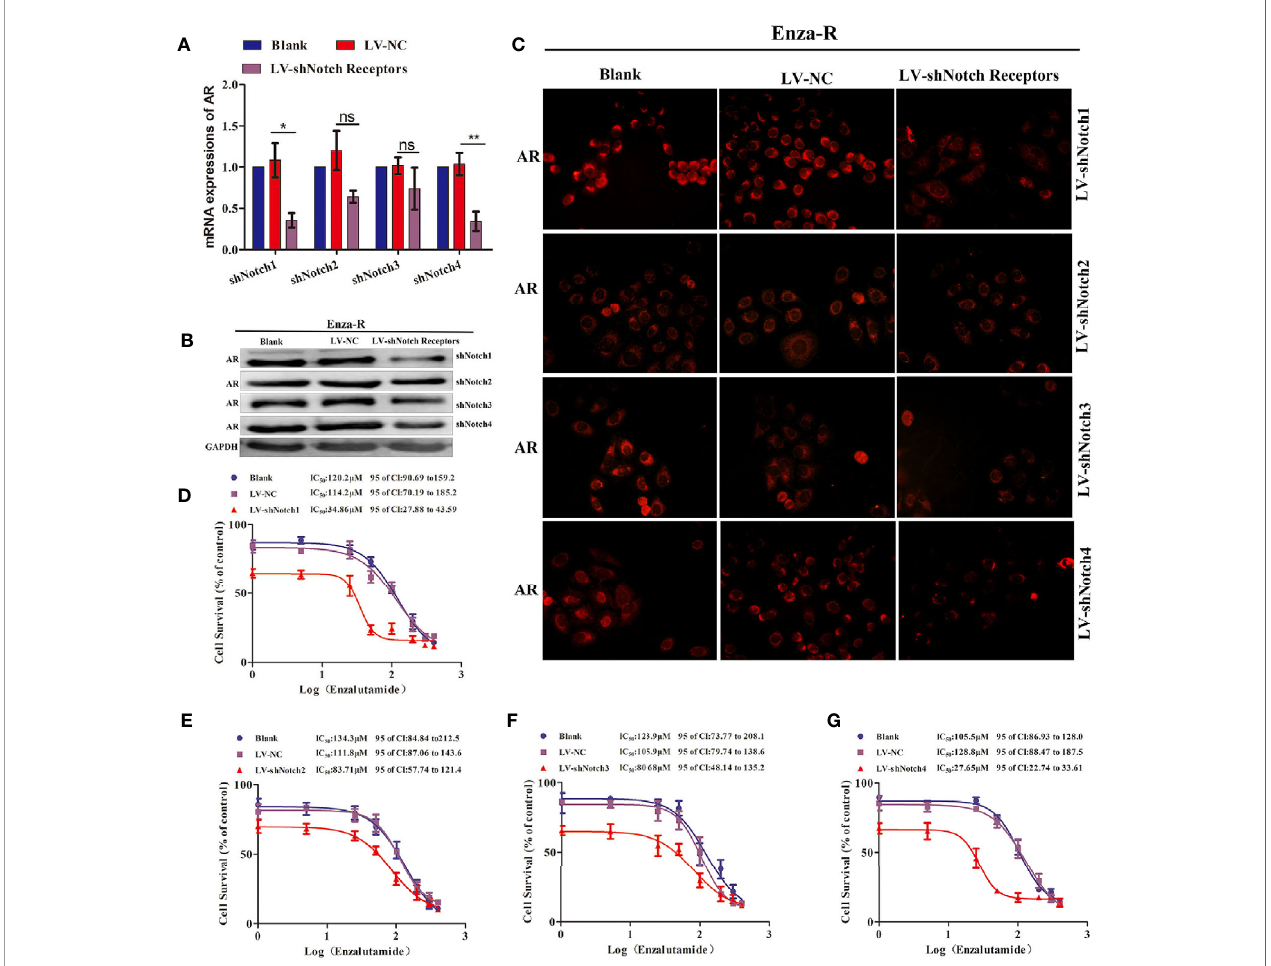
FIGURE 5 | Knocking down Notch receptors inhibited the expression of AR and reversed the enzalutamide resistance in Enza-R cells. (A – C) Expression of AR in Enza-R cells infected with LV-shNotch1, LV-shNotch2, LV-shNotch3, LV-shNotch4 were respectively determined by using RT-PCR, Western blot and Immuno fl uorescence (magni fi cation, ×200) assay. *P < 0.05, **P < 0.01, ns, no signi fi cance. (B – G) The half maximal inhibitory concentration (IC50) was determined by CCK-8 assay after the cells were treated with increasing concentrations of enzalutamide for 24 h. Enza-R cells were infected with LV-NC or LV-shNotch1, LV- shNotch2, LV-shNotch3, LV-shNotch4 respectively. AR, androgen receptor; Enza-R, enzalutamide-resistant LNCaP